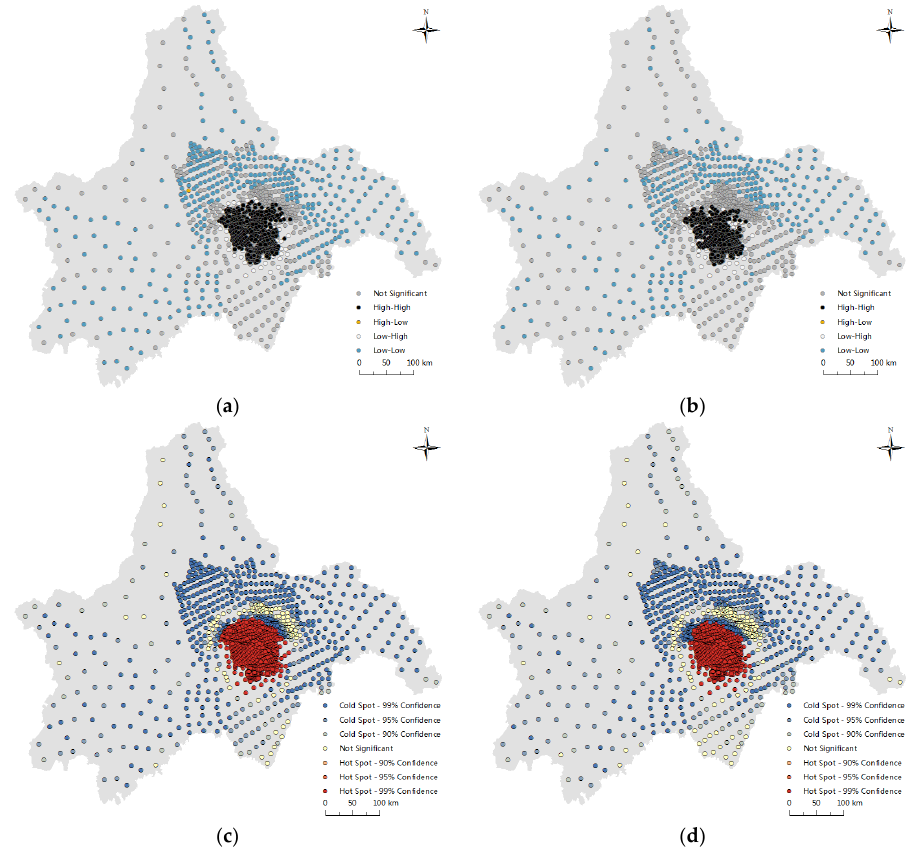
Figure 3. The spatial distribution of housing selling prices and housing rental prices in Chengdu in 2016. Note: ( a ) The spatial clustering of housing selling prices (high-high, low-low); ( b ) The spatial clustering of housing rental prices; ( c ) The distribution of hot spots of housing selling prices (confidence levels were 90%, 95% and 99% respectively); ( d ) The distribution of hot spots of housing rental prices. Table 4. Spatial autocorrelation analysis of housing prices ( n = 1431).